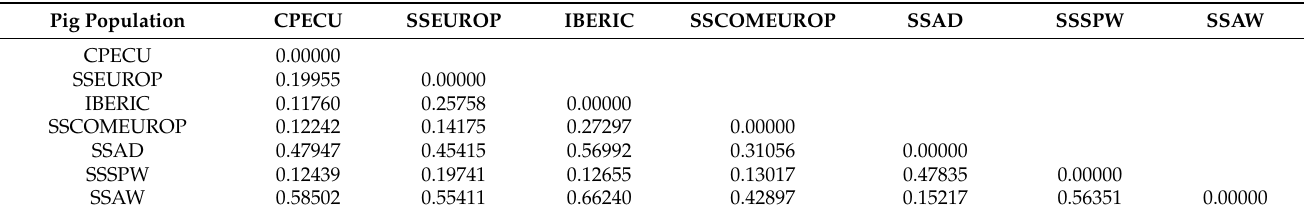
Table 3. Pairwise genetic differentiation (F ST —permuting haplotypes among population among groups) of populations.